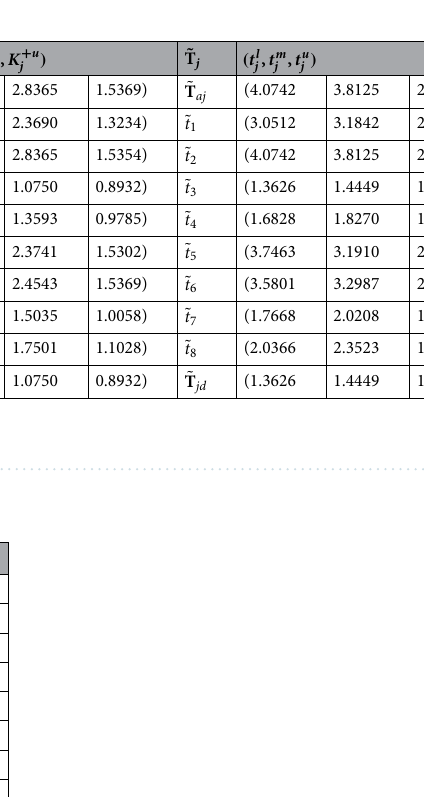
Table 10. Results of fuzzy MARCOS method and ranked order of the strategies.